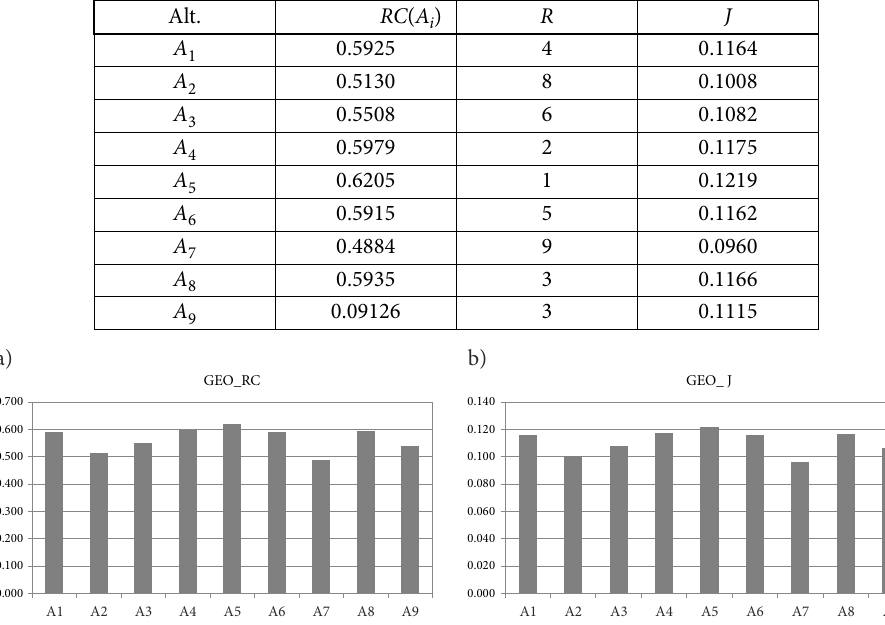
Table 9. Rankings of gerontechnologies after using the aggregation operator (19) with objective criteria weights